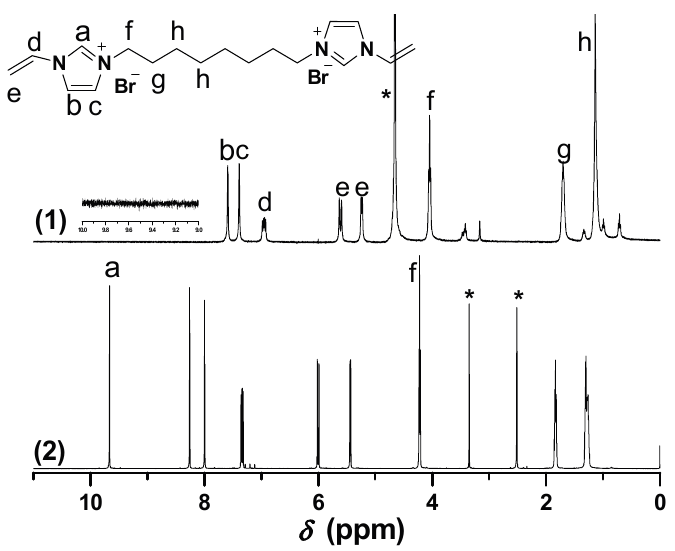
Figure 2. 1 H-NMR of [C 8 VIm]Br in different deuterium solvents. ((1) D 2 O; (2) DMSO- d 6 ). * The peak is ascribed to the solvent.